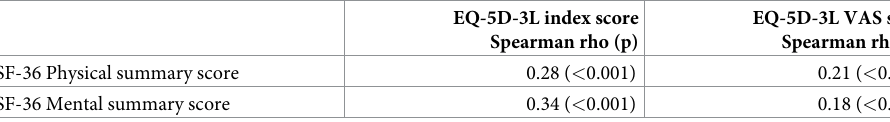
Table 4. Correlation of SF-36 summary scores with EQ-5D-3L